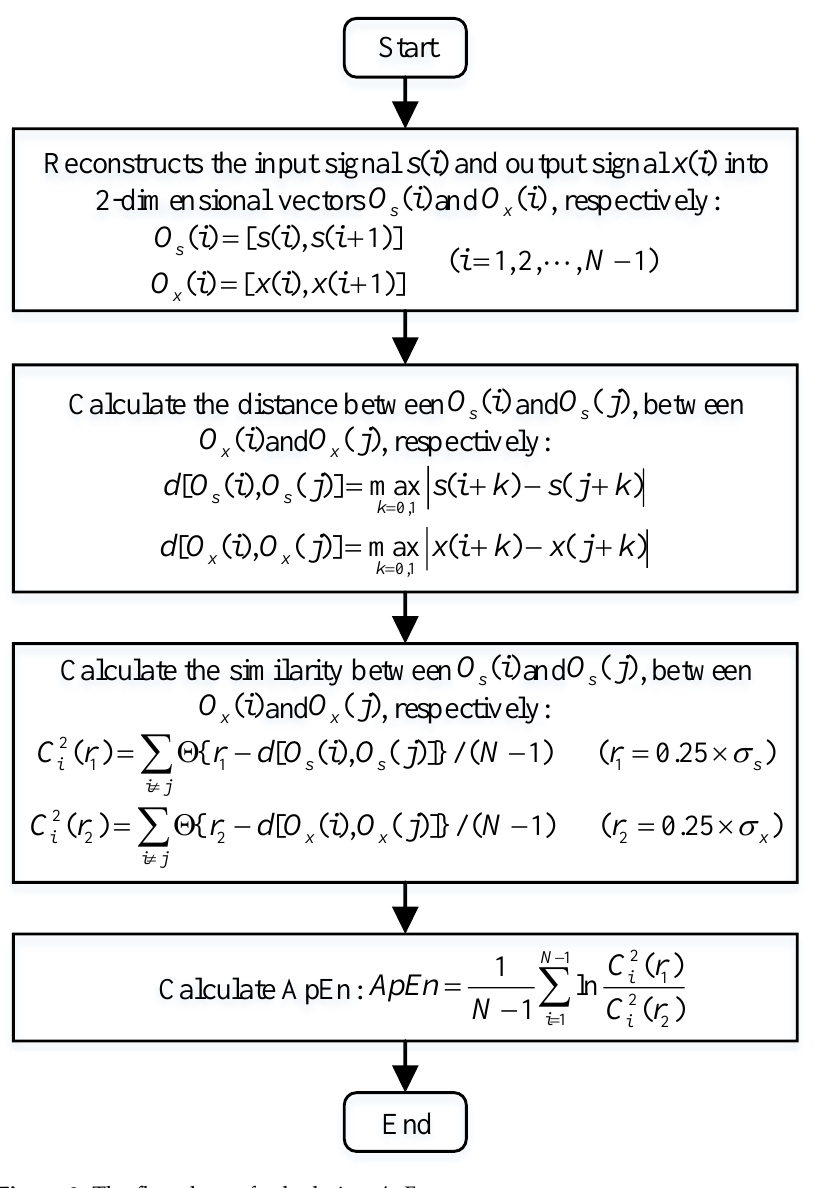
Figure 3. The flowchart of calculating ApEn . where σ s is the standard deviation of s ( i ), σ x is the standard deviation of x ( i